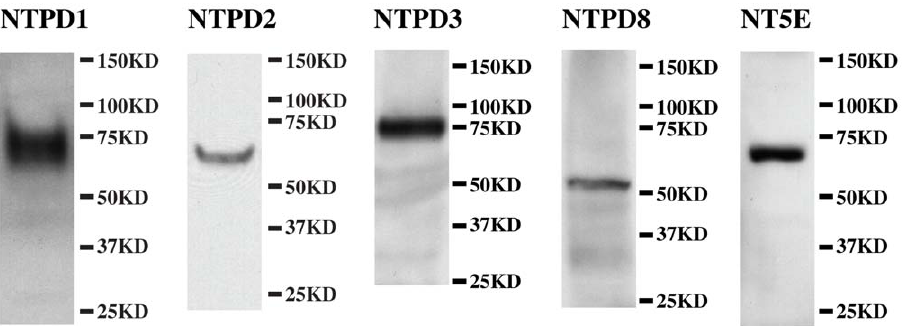
Figure 2. Western blotting for four ectoenzymes of the NTPD family and NT5E. Lysates of mouse bladder (25 m g protein/lane) were resolved by SDS-PAGE, and Western blots were probed with antibodies specific for five ectonucleotidases. Protein bands of the correct molecular weight were detected for each enzyme.